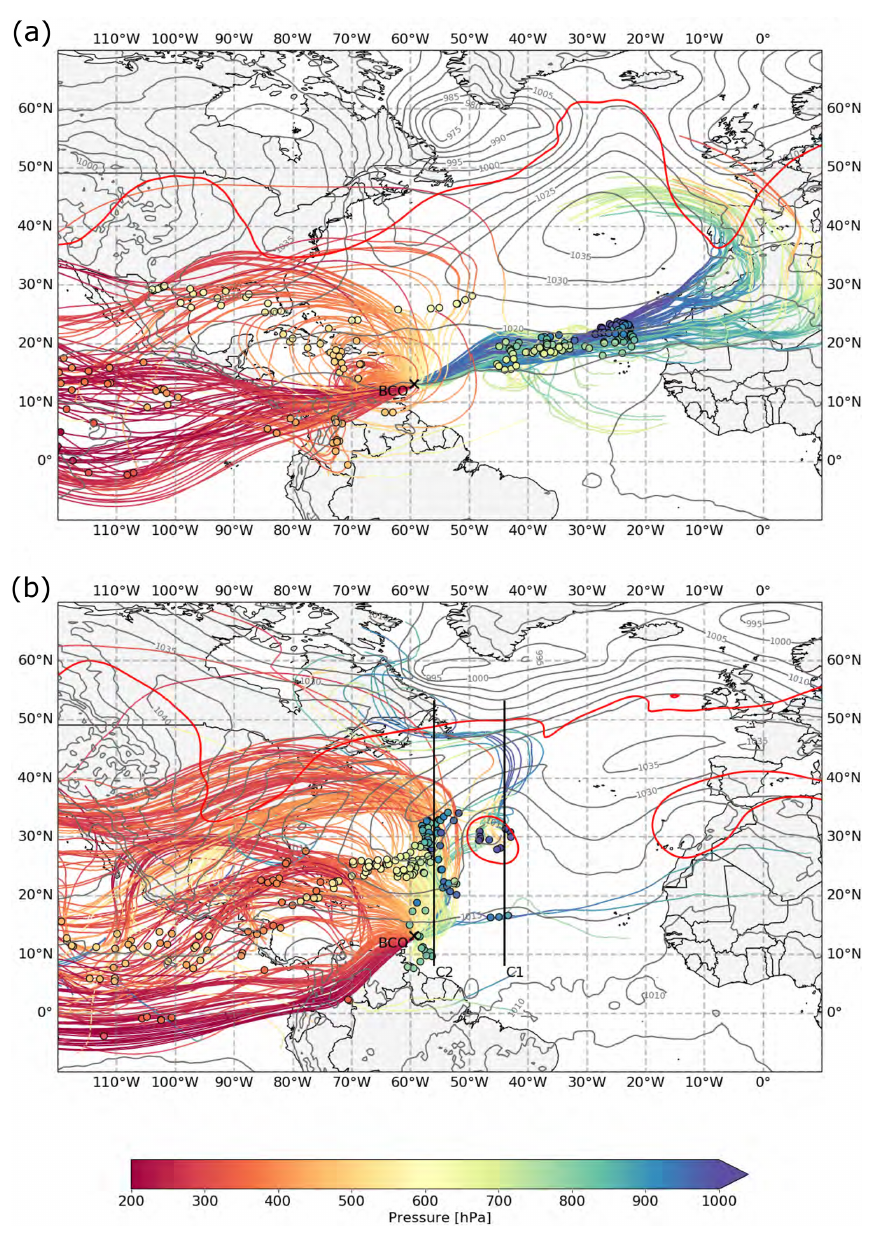
Figure 11. Back trajectories from the BCO started at (a) 15:00UTC on 29 January 2018 (extratropical trade wind regime) and (b) 15:00UTC on 2 February 2018 (extratropical dry intrusion regime). The trajectories are coloured according to their pressure. The position 4d before arrival above Barbados is indicated by a dot coloured with their arrival pressure at the BCO (blue in the sub-cloud layer, green in the cloud layer, orange in the free troposphere and red in the upper troposphere). The black cross indicates the location of Barbados (BCO). The grey contours show the sea level pressure, and the red contour denotes 2pvu at 320K 4d before